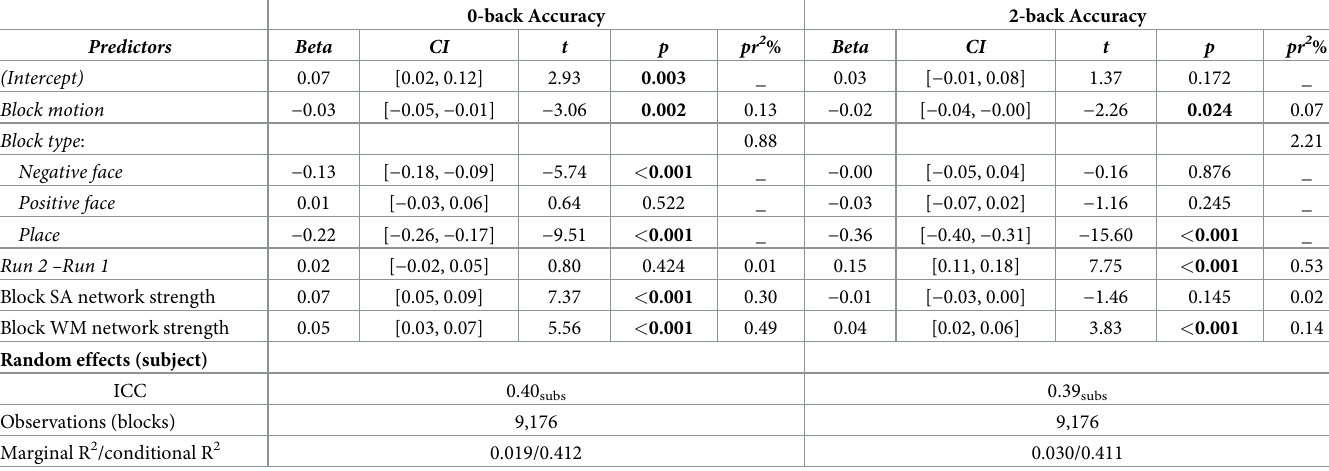
Table 2. Block-by-block networks strength and task performance.